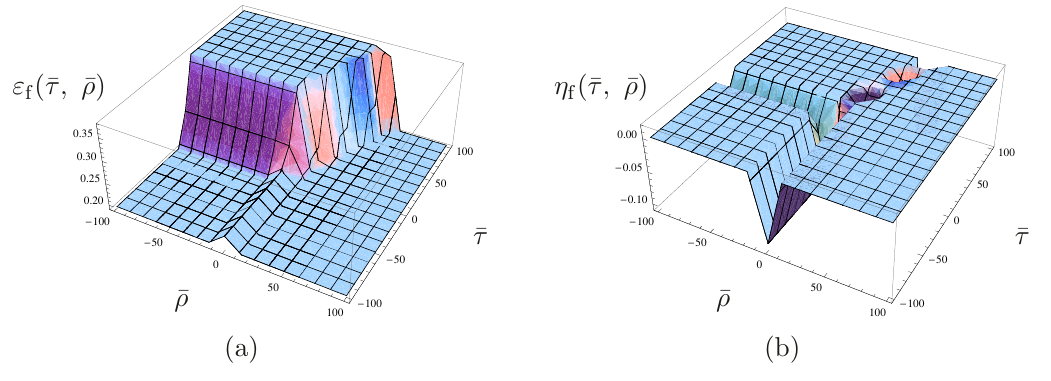
Figure 2 . For the case of R (Y) = 1, A Y = 1, A H = A p = A D p = 0, and A O p 1 , ( p = 4 , 6 , 8), in the moduli potential (2.12) of the type IIA theory, the parameters ε f (¯ τ, ¯ ρ ), η f (¯ τ, ¯ ρ ), are depicted. We set κ = 1 [34]. Since these results give the contradiction with the fast-roll condition for ekpyrosis (2.13), the ekpyrosis is not